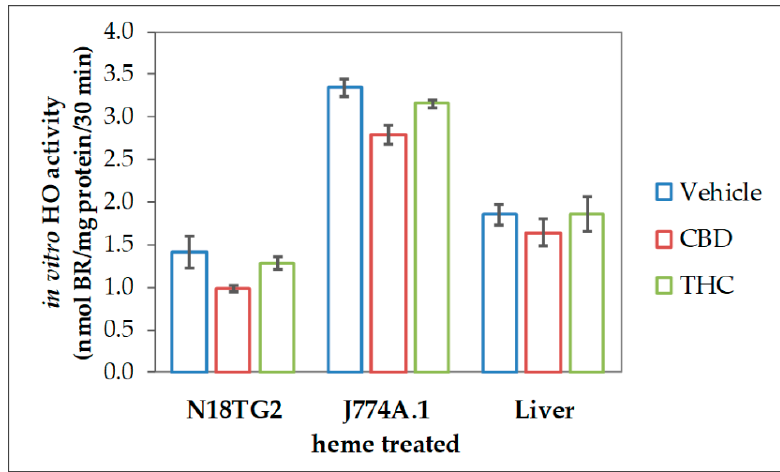
Figure 2. Cannabidiol exerts inhibitory effects on heme oxygenase activity in variable tissues. We used homogenized N18TG2 cells and J774A.1 cells, which were treated for 24 h with heme (20 µM), as well as liver homogenates, prepared as described in the Material and Methods section. Heme oxygenase (HO) activity was determined in the presence of vehicle (DMSO), cannabidiol (CBD; 10 µM), or tetrahydrocannabinol (THC; 10 µM) as described in Material and Methods. Each data point represents the mean ± SD from two experiments ( n = 2), which were measured in duplicates. Therefore, statistical analyses were not performed.